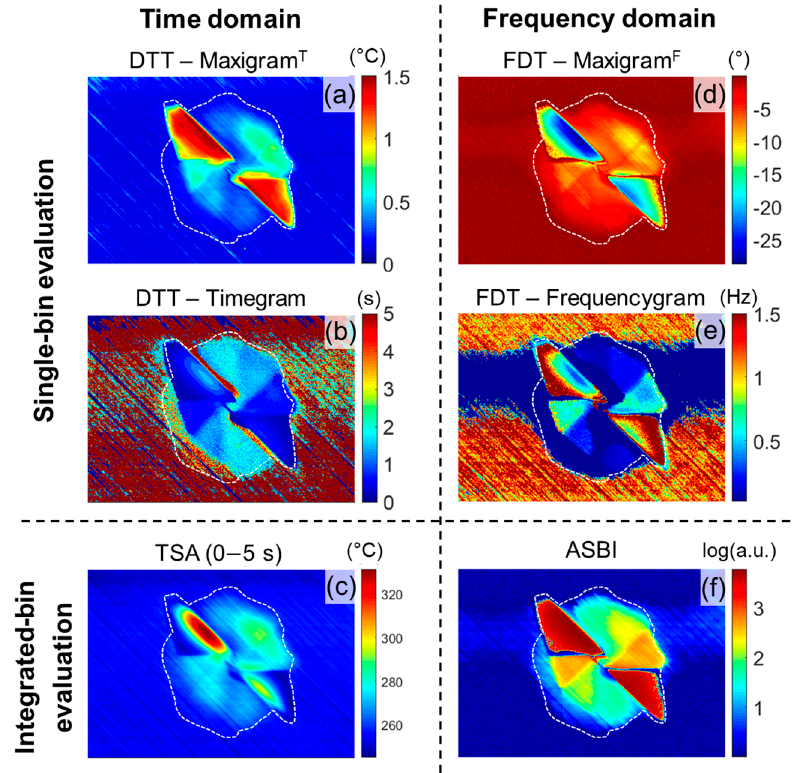
Figure 8. Results of processing techniques for the back side of the CFRP BVID coupon: ( a , b ) DTT maxigram T ∆ T max andtimegram t ∆ T , max ; ( c )TSA(0–5s); ( d , e )FDTmaxigram F ∆ ϕ max andfrequencygram f ∆ ϕ , max ; and ( f ) ASBI damage index